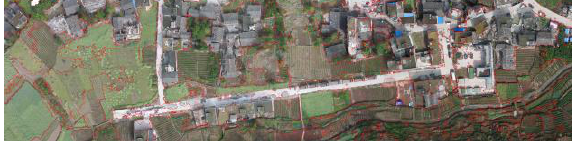
Figure 9. The optimal segmentation using dynamic programming